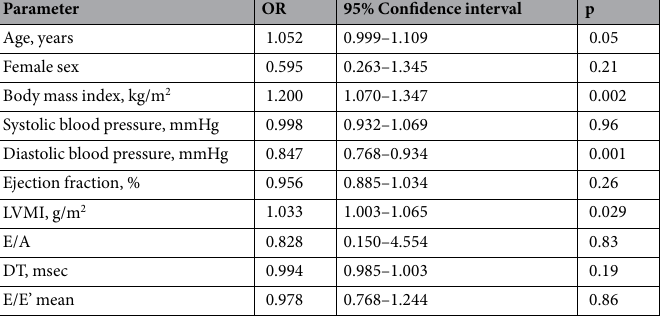
Table 3. Multivariable analysis of baseline characteristics and echocardiographic parameters associated with type 2 diabetes. LVMI-left ventricular mass index, E/A-ratio of early to late mitral valve flow velocity, DT-